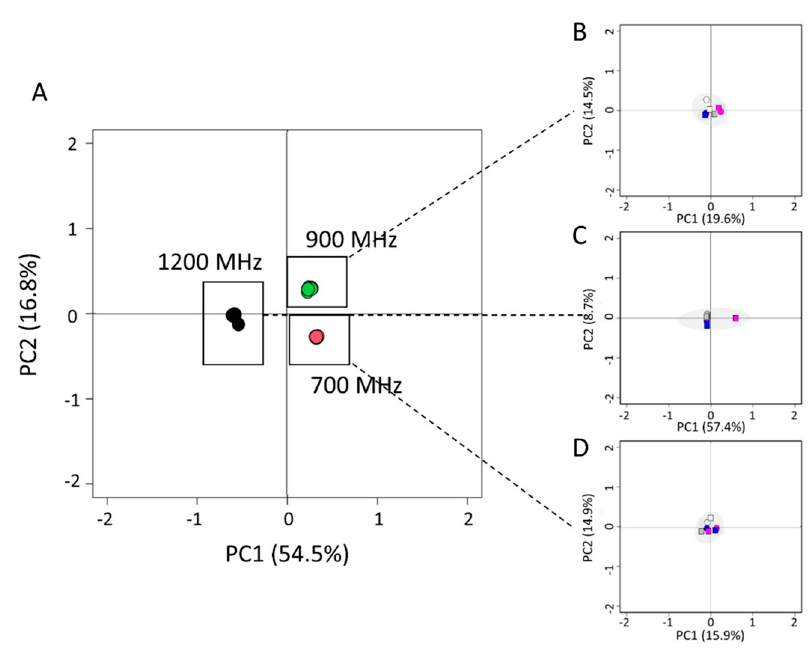
Figure 3. PCA score plot of 1 H- 13 C methyl correlation spectra acquired on batches 19G and 20G at 700 (red dots), 900 (green dots), and 1200 MHz (black dots) over time ( A ). PCA score plots of batch 19G (squares) and 20G (circles) NMR spectra acquired at 900 ( B ), 1200 ( C ), and 700 MHz ( D ) over time: just thawed (white), after seven days (gray), after 30 days (blue), and after 60 days (magenta).